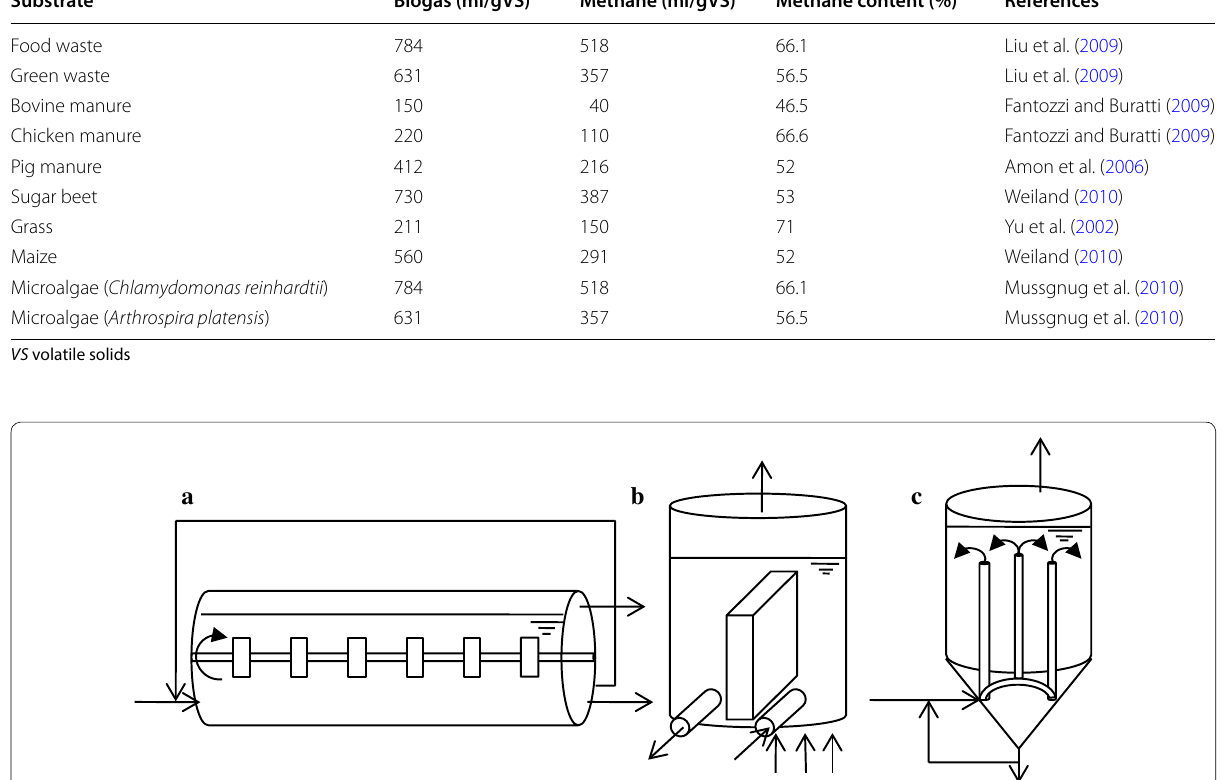
Fig. 3 Plug flow digesters for biogas production. a “Kompogas” reactor. Horizontal plug flow reactor. Additional mixing by axial mixer. Increased process condition stability by partial effluent recycling. Gas outlet on top of the outlet side. 23–28% total solids. b Valorga reactor. Substrate entry at the bottom; plug flow over a vertical barrier to the outlet. Additional mixing by biogas injection at the bottom. 25–35% total solid content. c Dranco reactor. Substrate entry wit partial effluent recycling at the bottom, upward flow through substrate pipes. Downward plug flow to outlet. 30–40% total solids (Li et al. 2011; Nizami and Murphy